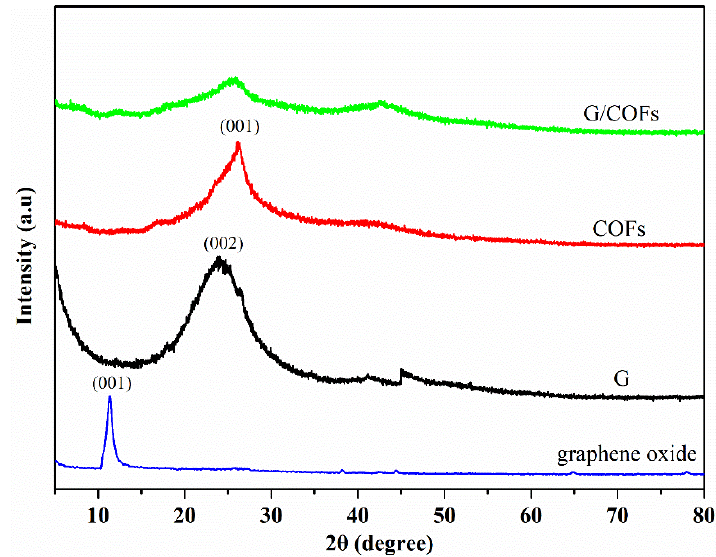
Figure 2. XRD patterns of graphene oxide, G, COFs, and G/COFs.